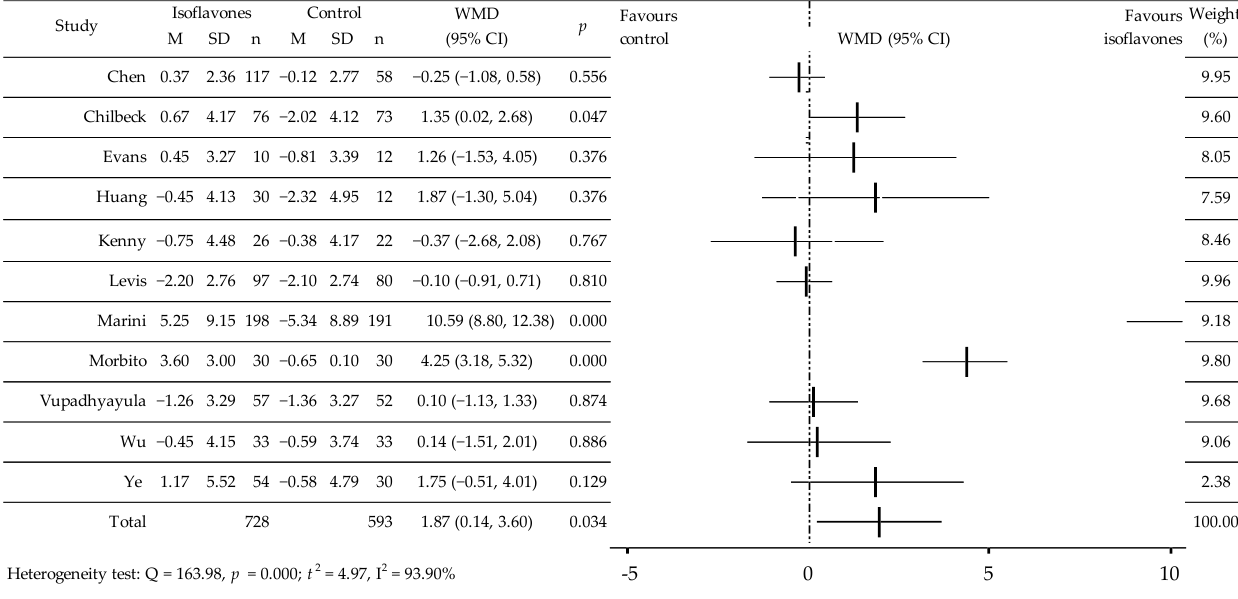
Figure 3. Effect of soy isoflavones on femoral neck bone mineral density in postmenopausal women compared to placebo [27,28,32–36,38–40,42]. M, mean change from baseline (%); SD, standard deviation; n, size of the study group; WMD, weighted average difference (%); CI, confidence interval; horizontal lines correspond to 95% CI (some of them go beyond the boundaries of the scale.